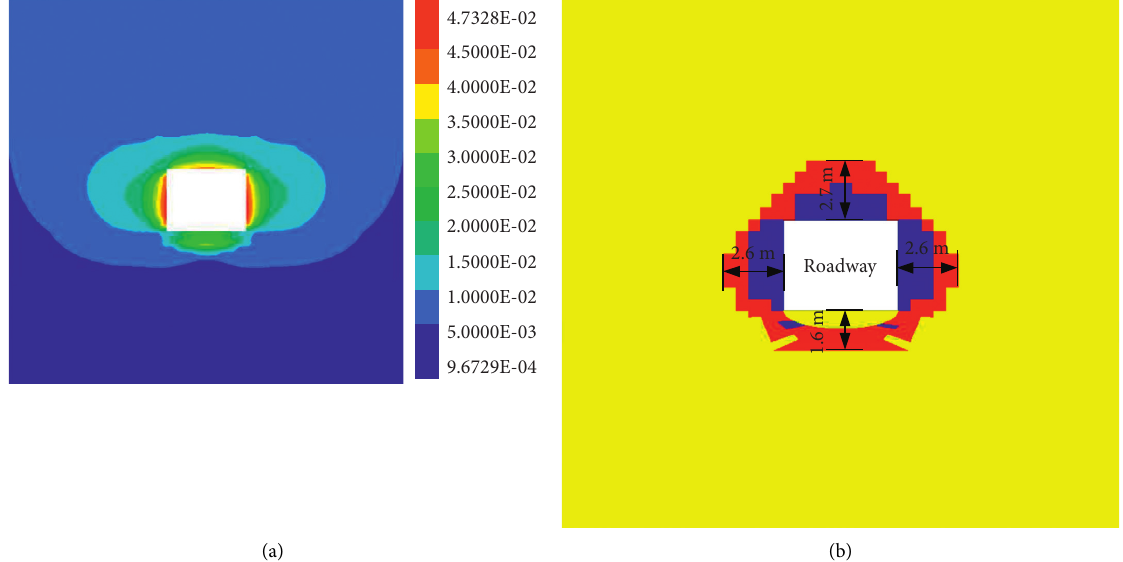
Figure 12: Numerical calculation results of displacement and plastic zone of surrounding rock in roadway with weak cemented soft rock roadway under new support scheme. (a) Displacement. (b) Plastic